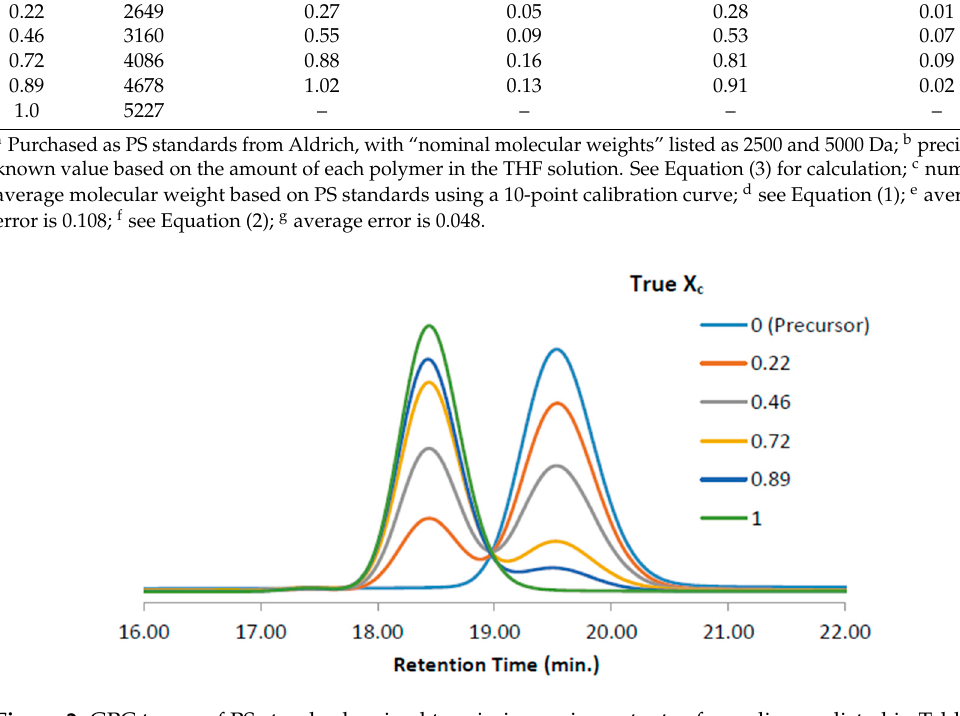
Figure 2. GPC traces of PS standards mixed to mimic varying extents of coupling, as listed in Table 1.